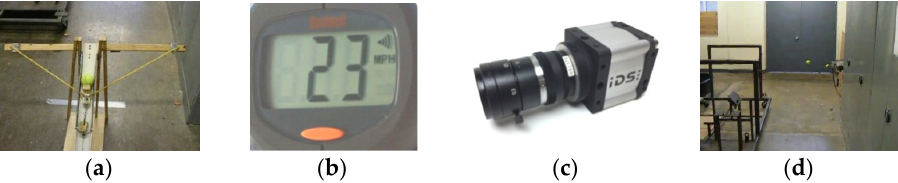
Figure 4. Real world experimental setup. ( a ) Ball throwing device. ( b ) Radar gun to measure launching speed. ( c ) Used camera (UI-1220RE-M-GL). ( d ) Trajectory captured through throw side camera.